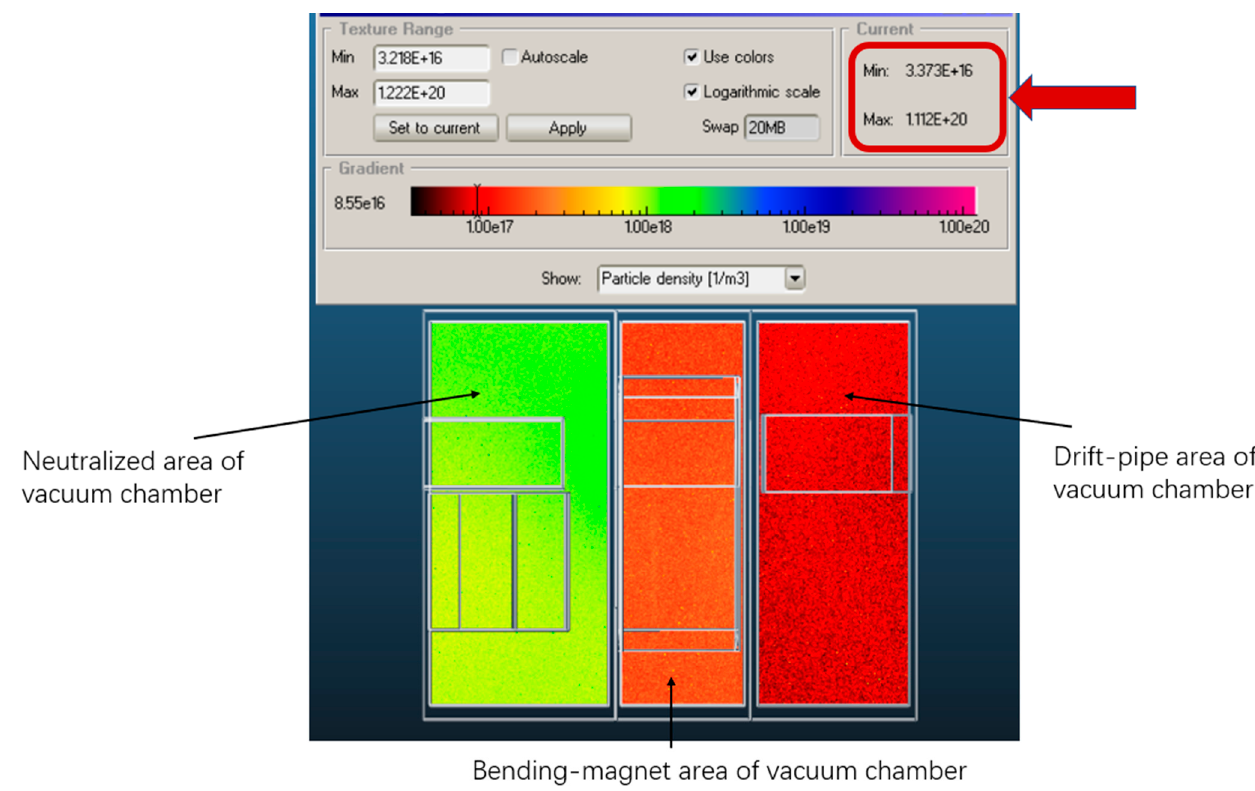
Figure 12. Cloud diagram of the heat-load distribution on the low-temperature condensation surface of each area after the vacuum chamber has been dynamically